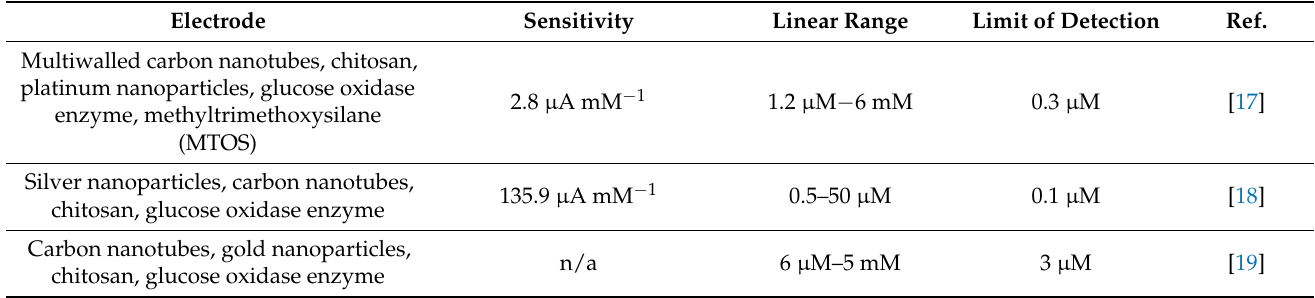
Table 2. Performance of reported different enzymatic glucose electrodes. Sensitivity Linear Range Limit of Detection